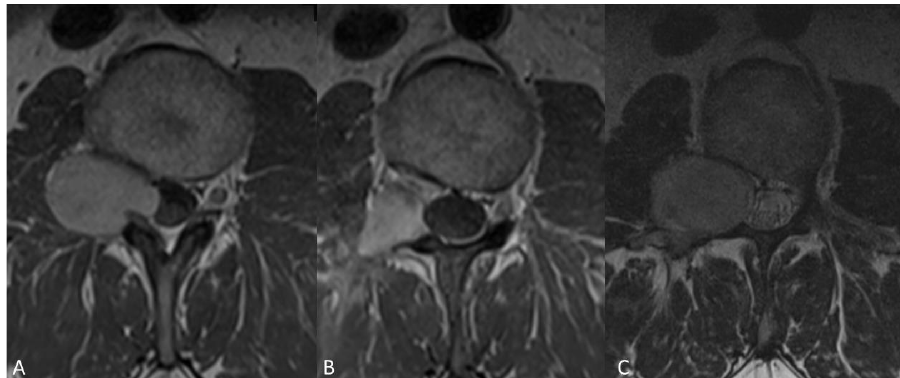
Figure 4. Case example of a 46-year-old male patient admitted with sciatica and low back pain. MRI demonstrated a space occupying lesion at the level of L 2–3, Eden type 3 ( A ), histology conformed a grade I schwannoma. Tumor resection was performed via dorso-lateral approach. Post-operative MRI, three months after surgery showed reduction of tumor volume with residual contrast enhancement ( B ) and patient was followed up. After a period of three years MRI demonstrated clear tumor progression ( C ) and patient had to be operated again.